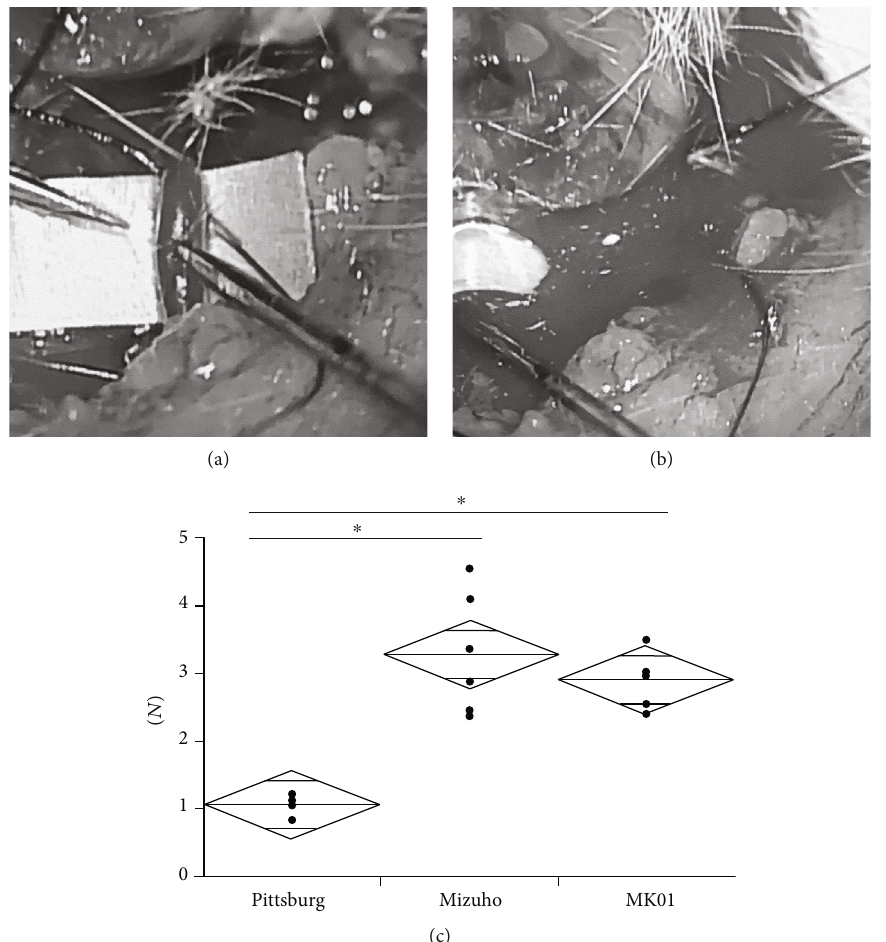
Figure 2: Photographs of compressing the cervical artery using the Pittsburg cannula (a) and of massive hemorrhage after arterial vessel penetration (b). Graph showing the force needed to penetrate the abdominal arterial wall with each cannula (c). The Pittsburg cannula required a signi fi cantly smaller force to penetrate the artery compared with the Mizuho and MK01 cannulas.